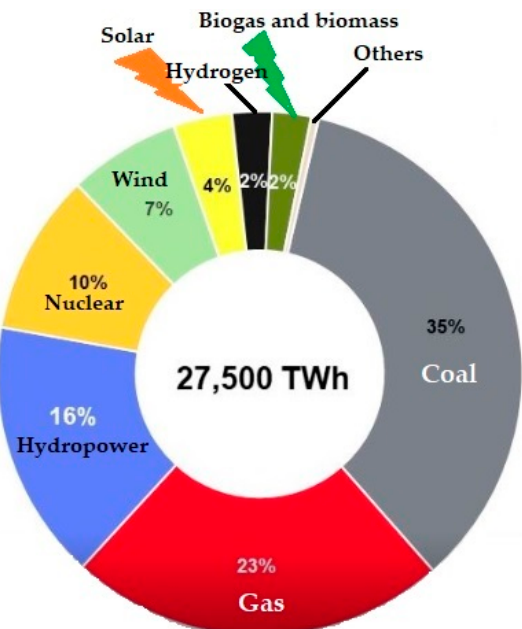
Figure 1. Global share of energy sources 2021 [13].